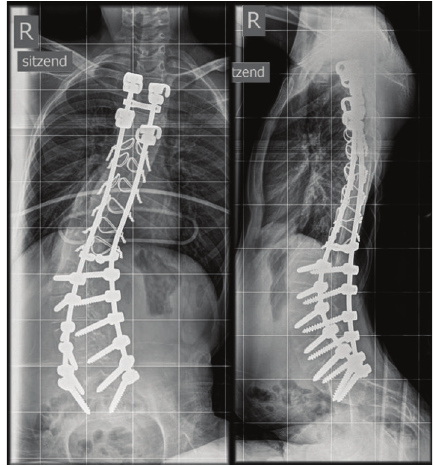
Figure 2: Male PD patient, 13 years old. Thoracic scoliosis 35 ∘ Cobb Th6/L1/L5, after surgical spine stabilization. Remaining 8 ∘ of pelvic obliquity to the right. AP and sagittal